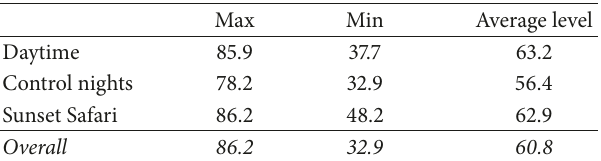
Table 8: Maximum, minimum, and average decibel levels for each observation period and